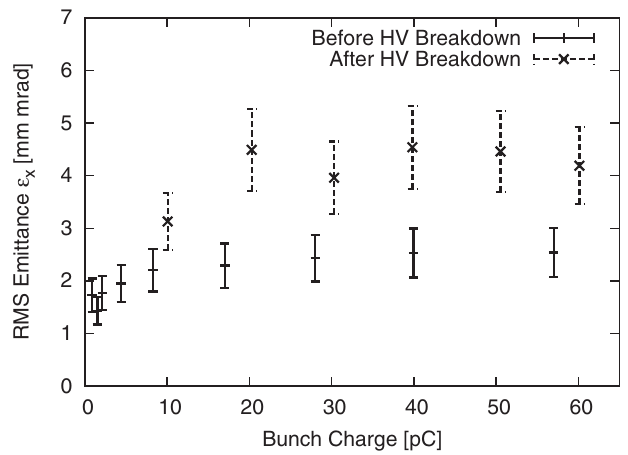
FIG. 7. Transverse rms emittance measured as a function of bunch charge. A significant emittance increase was observed after a HV breakdown incident; this is caused by inhomogeneous emission due to FEA surface